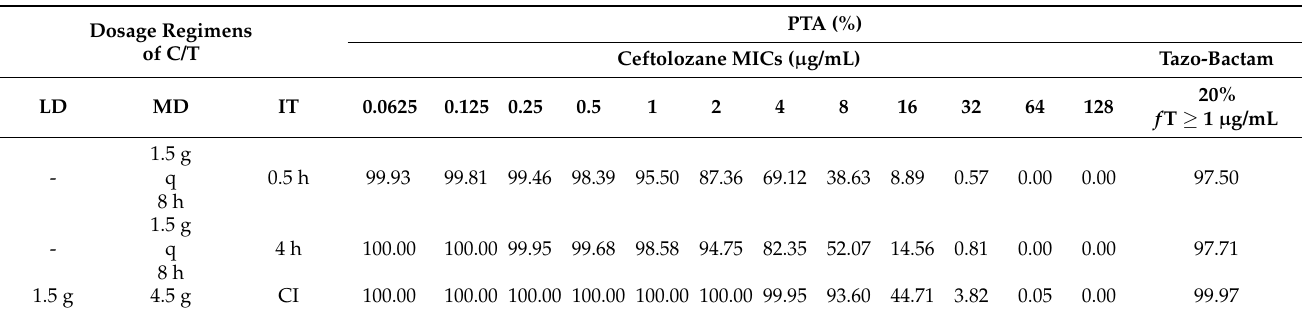
Table 5. The probability of target attainment (PTA), including 100% f T > MIC for ceftolozane and 20% f T ≥ 1 µ g/mL for tazobactam, at specific MICs for each dosing